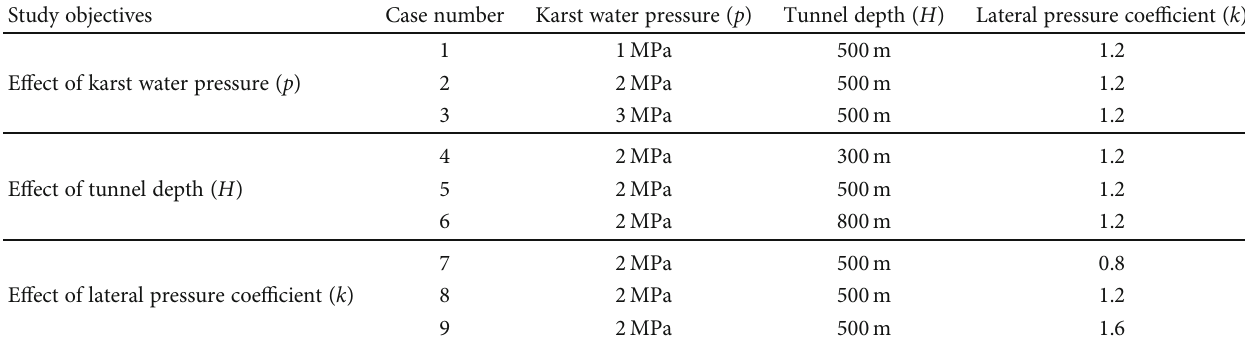
Table 3: The calculation scheme for the three in fl uential factors.